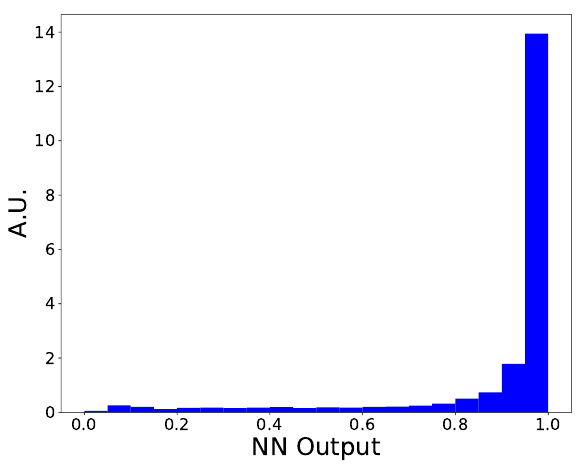
Figure 4 . Neural network output distribution on parton-level top